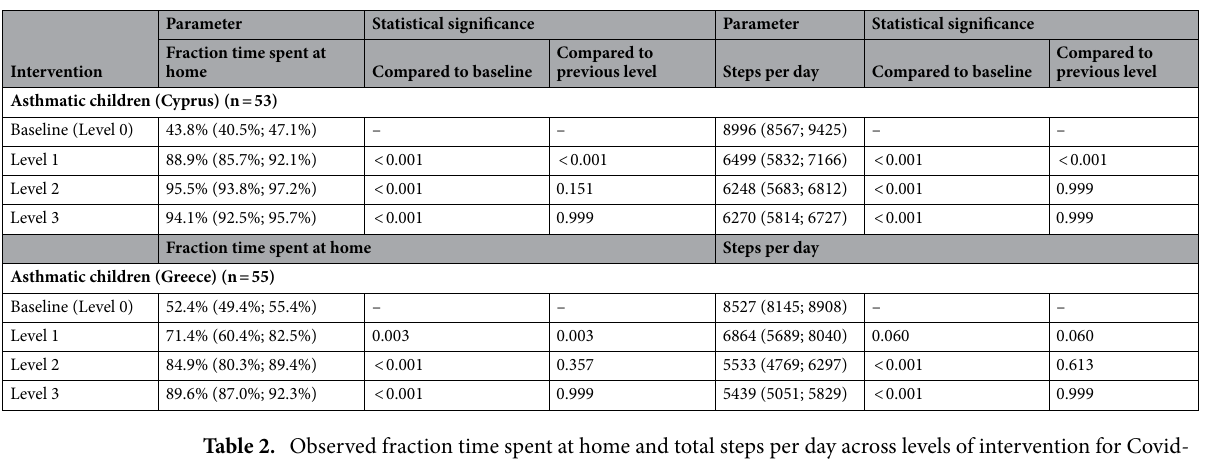
Table 2. Observed fraction time spent at home and total steps per day across levels of intervention for Covid- 19 in Cyprus and Greece. Values are presented as mean (95% Confidence Interval).